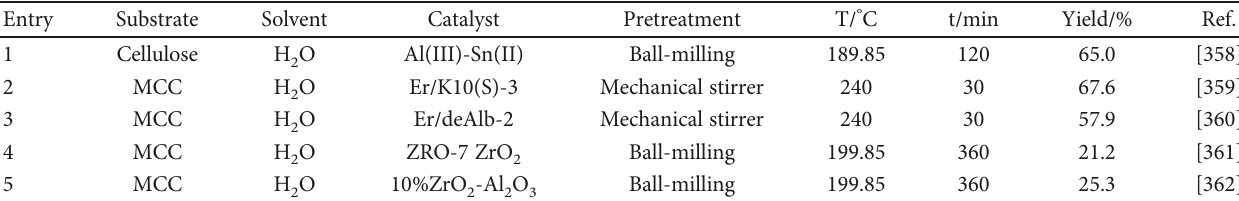
Table 7: Lactic acid yields obtained with various